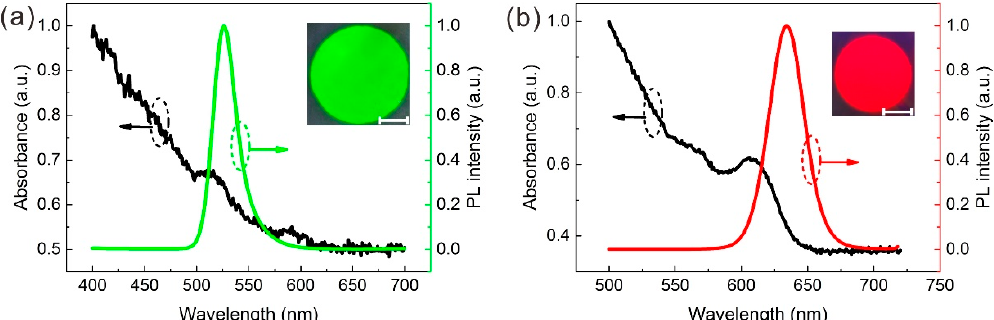
Figure 9. The absorbance and photoluminescence (PL) spectra of ( a ) green and ( b ) red quantum dot films. Inset are the physical pictures of films excited by 365 nm, white scale bar representing 2 mm.